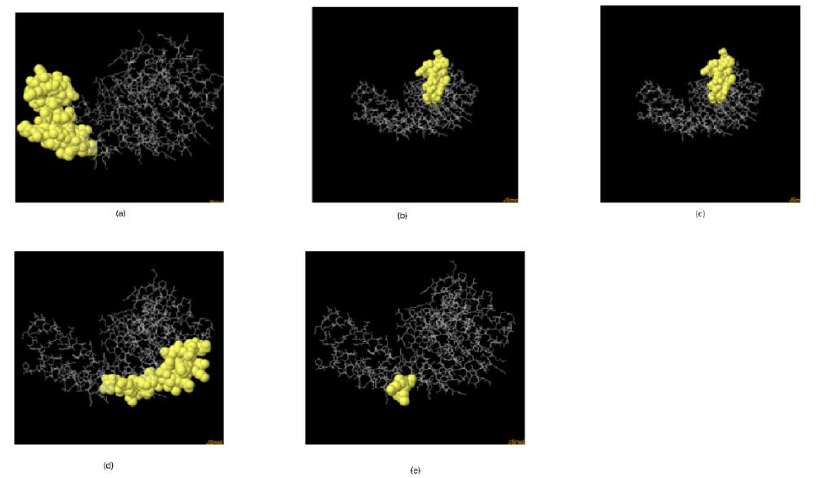
Figure 6. The 3D model of the 5 predicted conformational B-cell epitopes. The yellow regions are the conformational B-cell epitopes, while the grey regions are the residue remnant. ( a ) 21 residues has a score of 0.915; ( b ) 40 residues has a score of 0.758; ( c ) 46 residues has a score of 0.702; ( d ) 11 residues has a score of 0.674; ( e ) 6 residues has a score of 0.659.